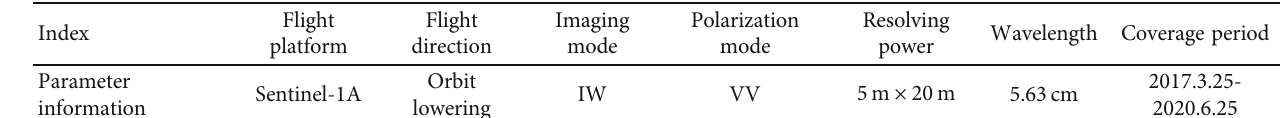
Table 1: Main parameters of data image.